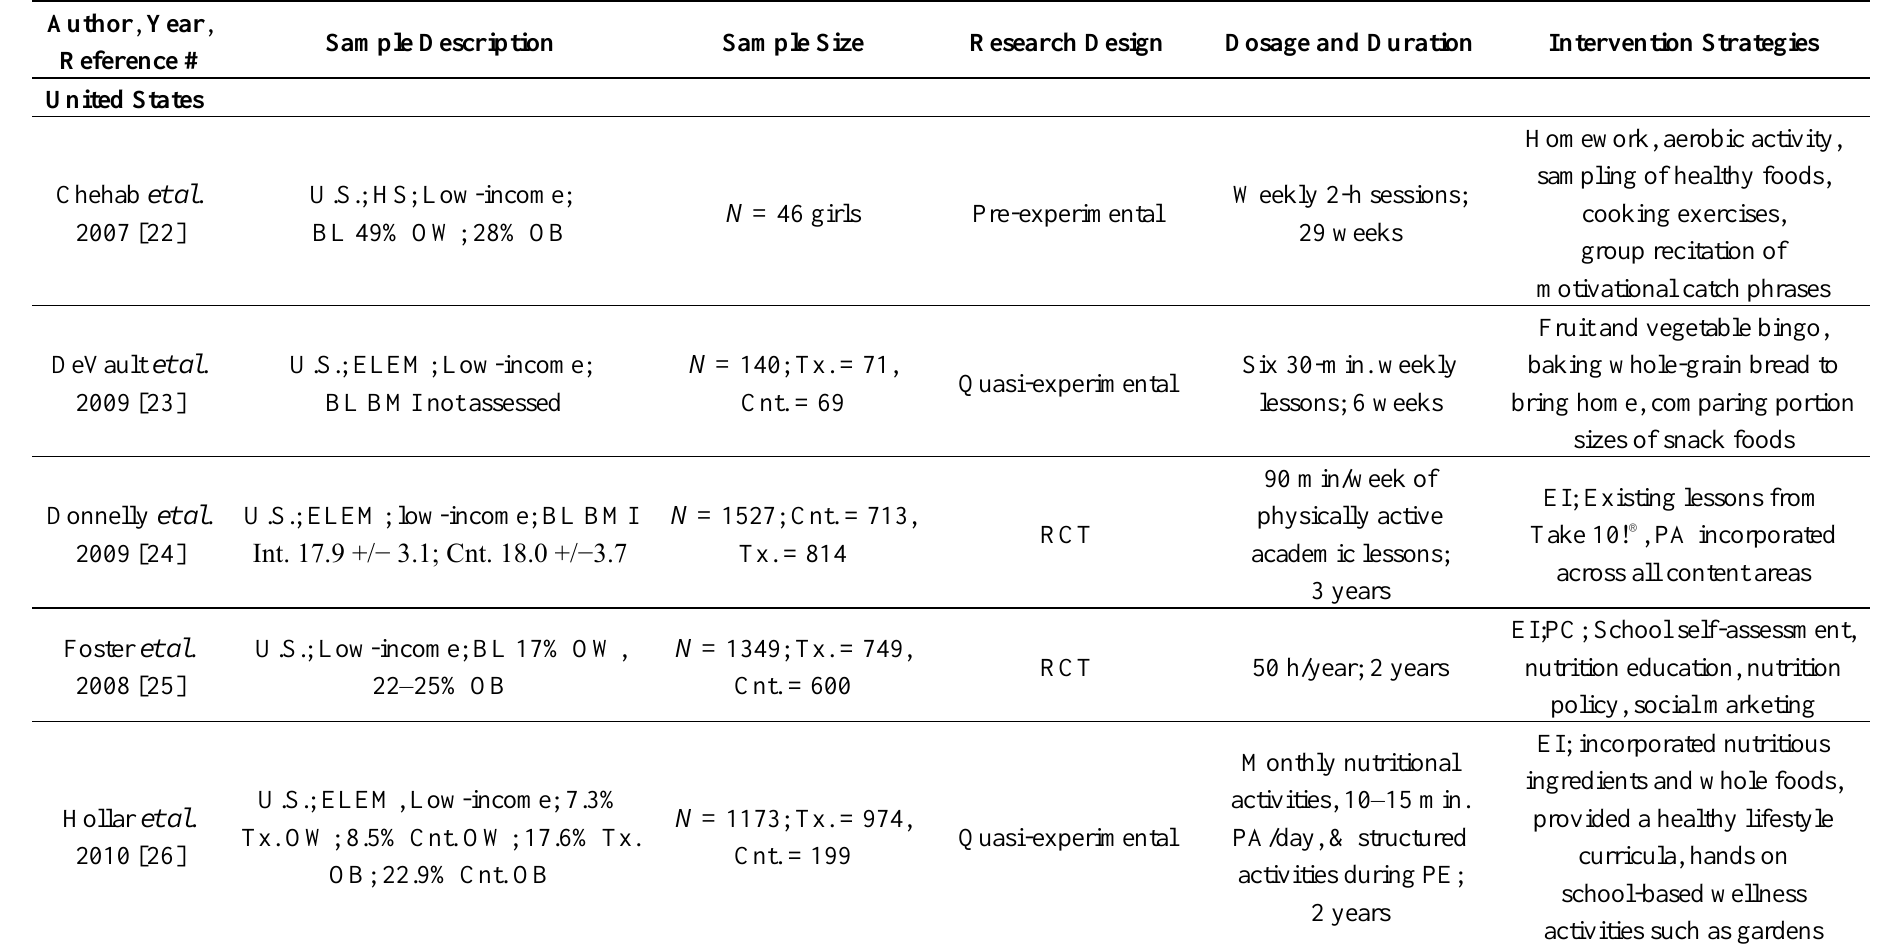
Table 1. Summary of included interventions—sample, design, intervention